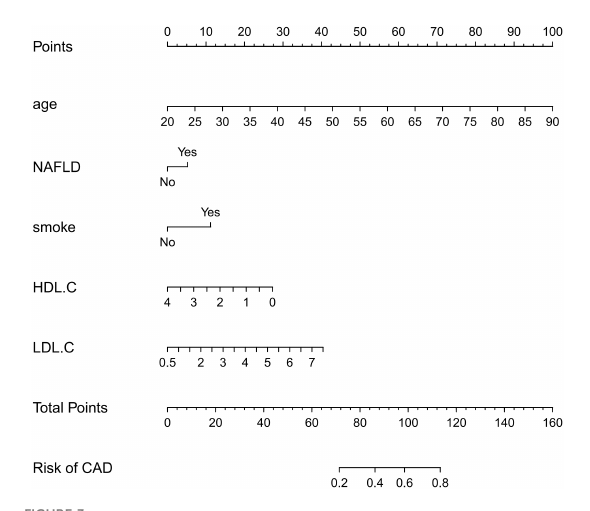
FIGURE 3 Nomogram: A Nomogram was created to determine the incidence of carotid atherosclerosis. A total score was obtained from the values of each index, and the CAD risk rate corresponding to the total score was the predicted rate of the